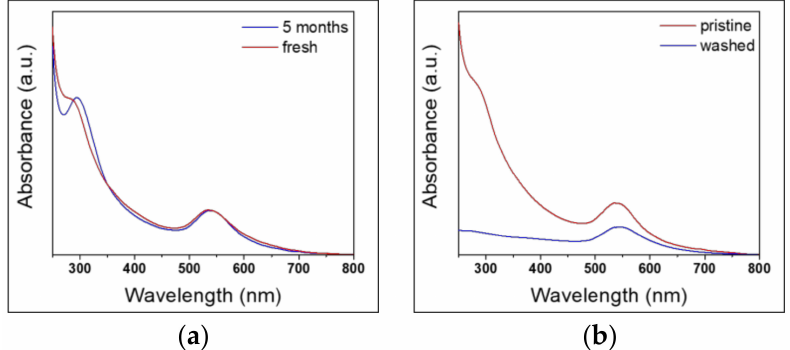
Figure 4. UV-Vis spectra of AuNPs. ( a ) 5-months aged 430-gold colloid compared with the fresh one; ( b ) washed 430-gold colloid compared with the pristine